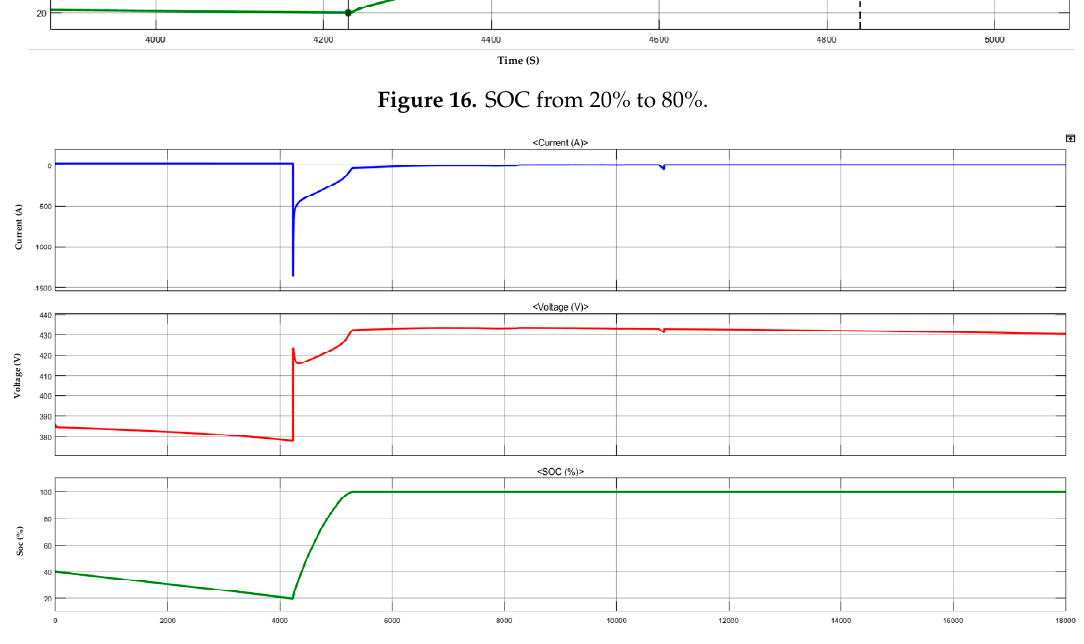
Figure 17. Characteristic curves for incoming electric vehicle (EV) battery